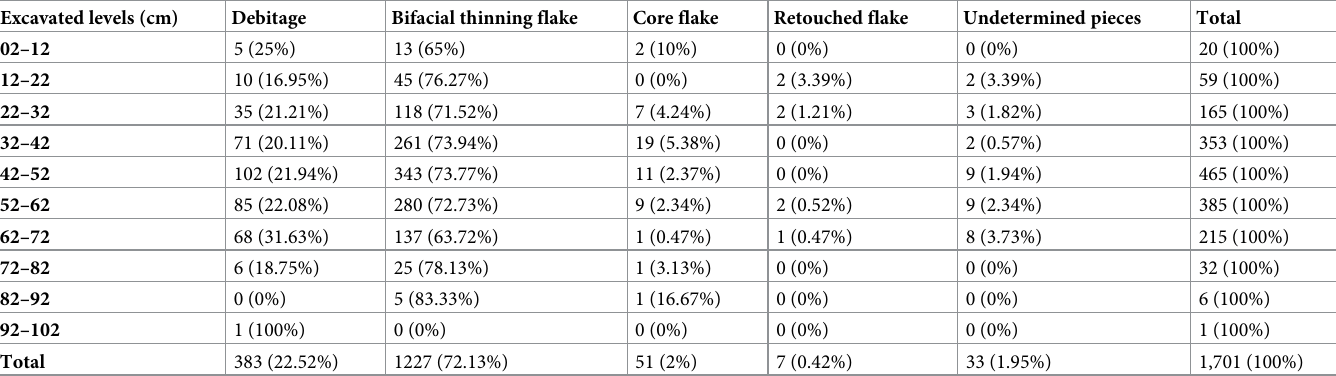
Considers only complete and proximal fragments of piece plotted specimens.